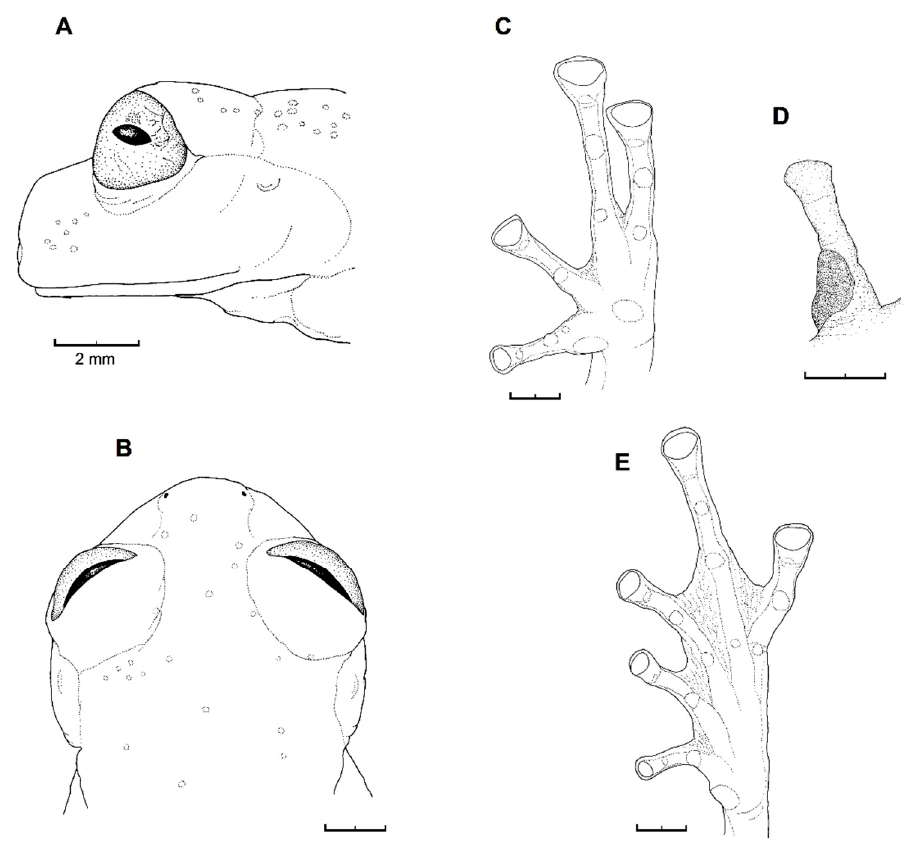
Figure 178. Nymphargus posadae , adult males from Yanayacu Biological Station, Napo province, Ecuador. ( A ) Head in lateral view, QCAZ 26023. ( B ) Head in dorsal view, QCAZ 26023. ( C ) Hand in ventral view, QCAZ 25090. ( D ) Finger I in dorsal view, QCAZ 26023. ( E ) Foot in ventral view, QCAZ 26023. Modified from Guayasamin et al. [20].